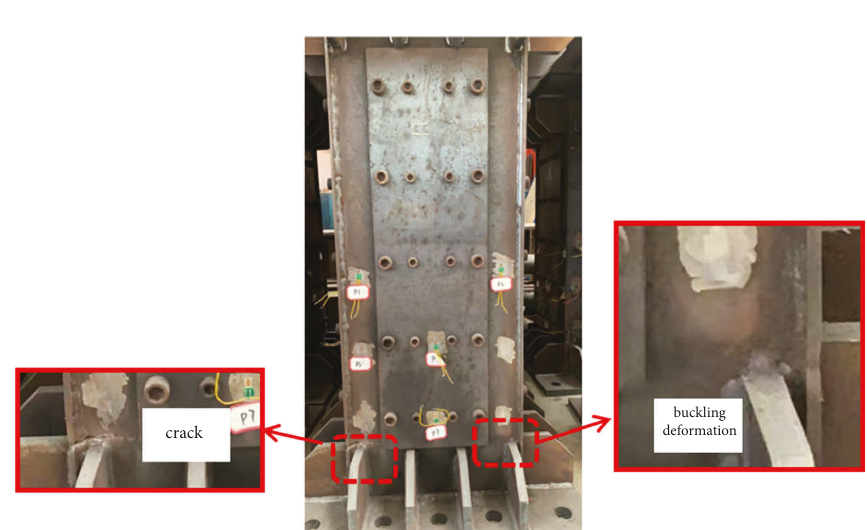
Figure 11: Failure mode of specimen III-2.